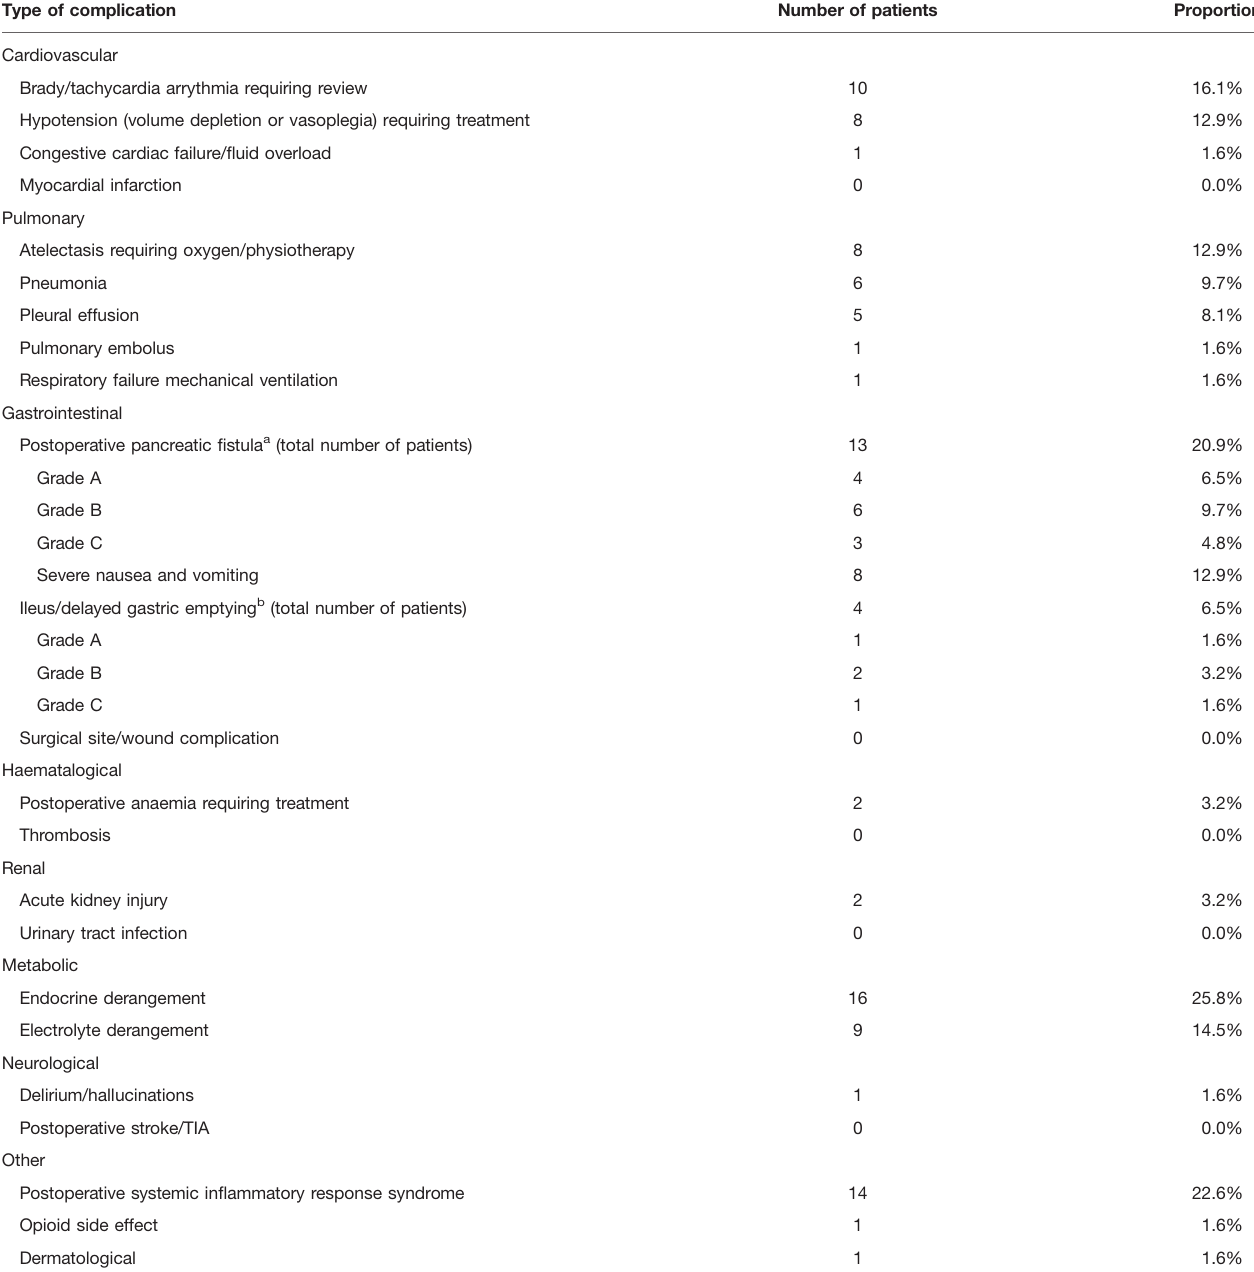
TABLE 3 | Types of complications. (Some patients had a more than one